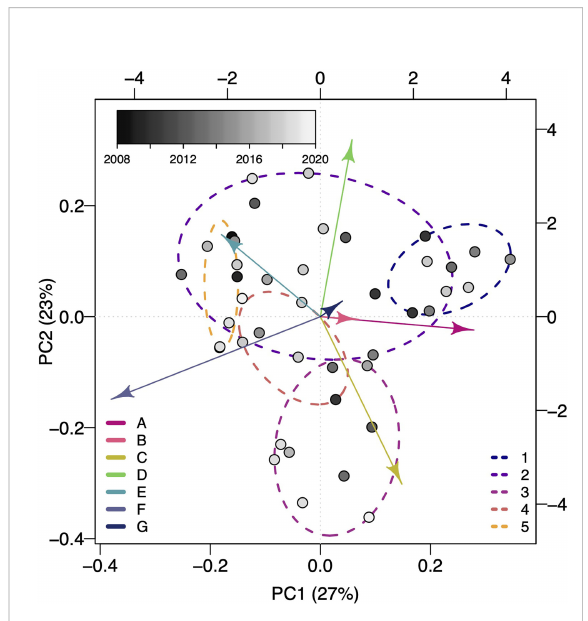
FIGURE 3 The fi rst and second principal components from a Principal Components Analysis of the proportion of subsurface movements per basking shark in each shape cluster. Each point represents an individual ’ s fi rst and second principal components score and is color-coded by the deployment year (lighter colors for more recent years). Arrows indicate the loadings of each of the seven subsurface movement shape clusters on the fi rst and second principal components. Dashed ellipsoids indicate the fi ve identi fi ed vertical movement behavioral strategies determined from a hierarchical clustering of movement summary metrics across all sharks (see Comparing subsurface movements across sharks for the